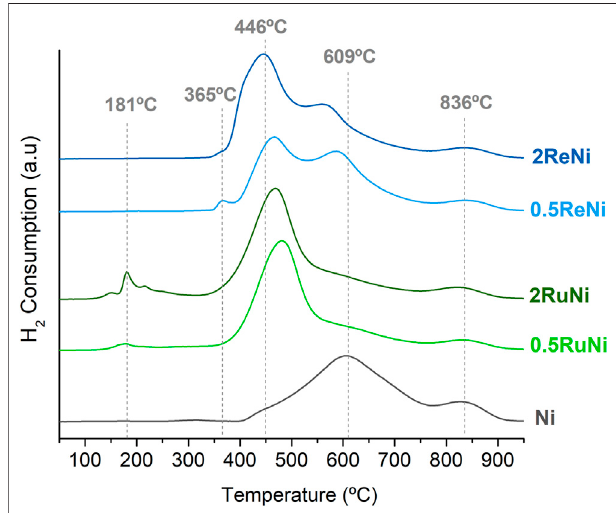
FIGURE 3 | H 2 -TPR pro fi les of the synthesized